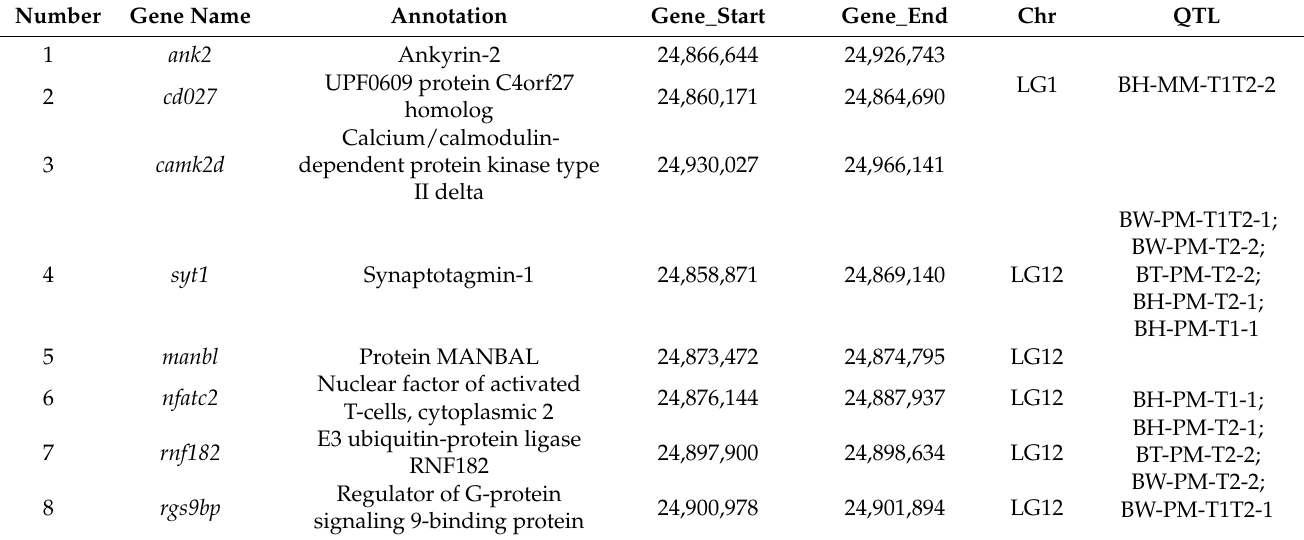
Table 4. Summary of the growth trait QTLs and candidate genes in Yellow River